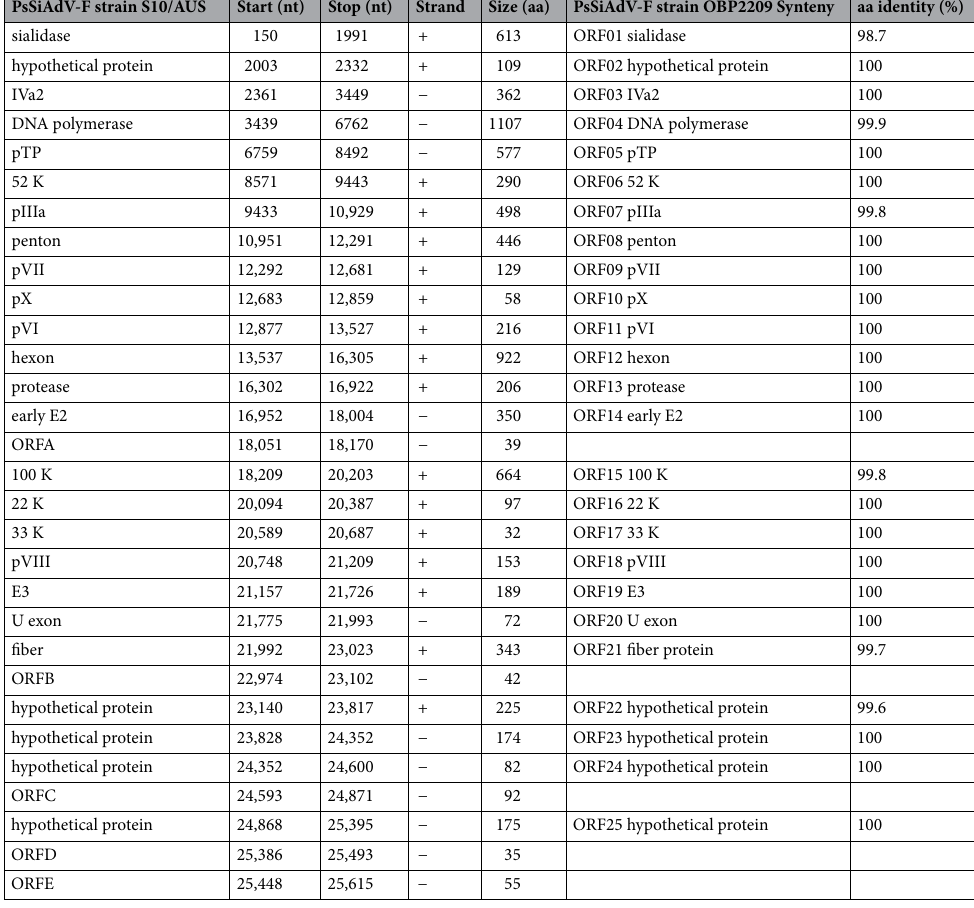
Table 1. Predicted protein-coding genes of PsSiAdV-F strain S10/AU. PsSiAdV-F, psittacine siadenovirus F; GenBank accession number of PsSiAdV-F strain OBP2209, MW365934; GenBank accession number of PsSiAdV-F strain S10/AU, MZ364296; aa, amino acid; nt,